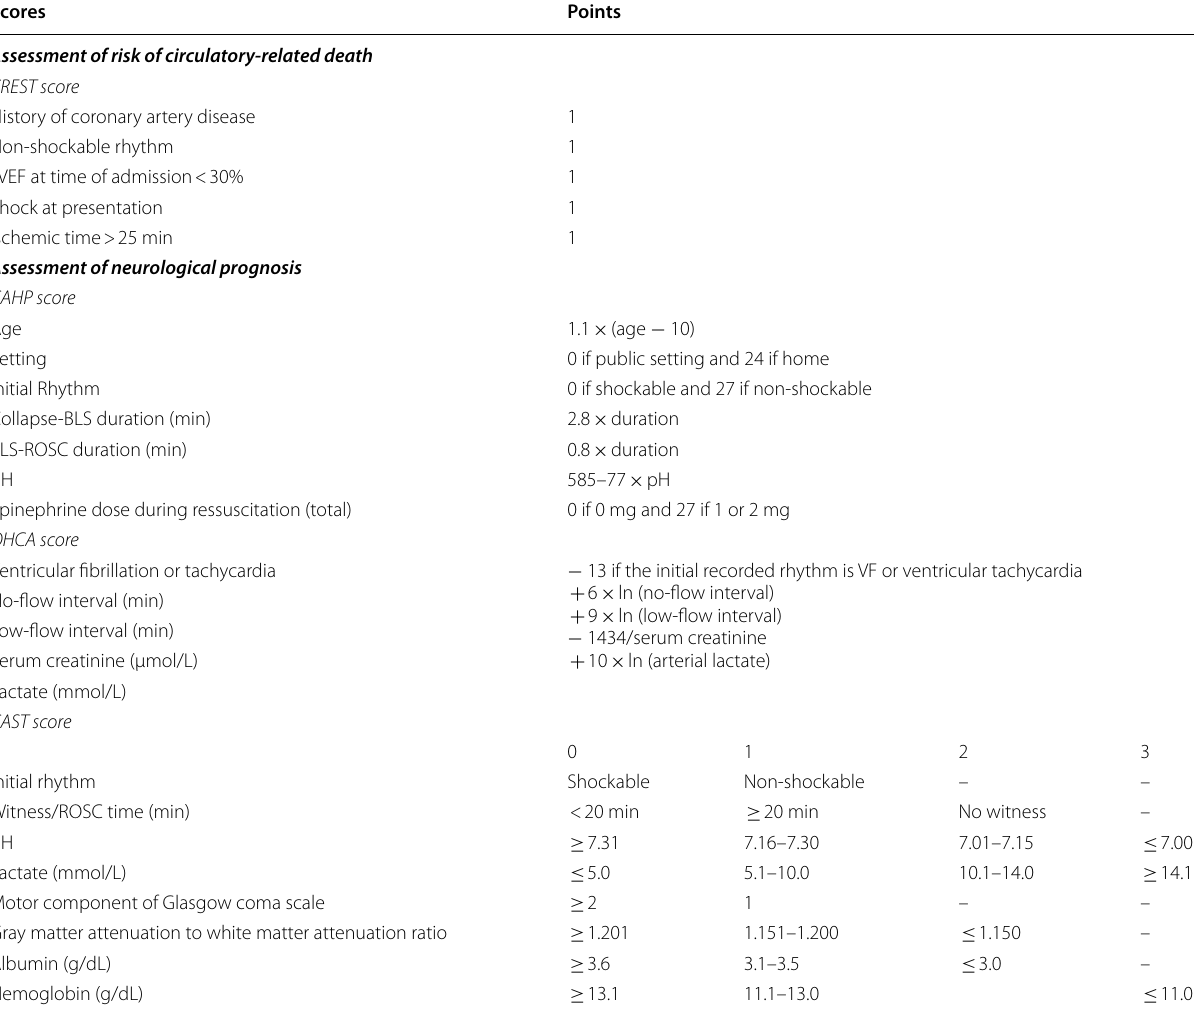
Table 1 Summarize of the different scores that can be used to select eligible patients with post‑resuscitation shock to extracorporeal life